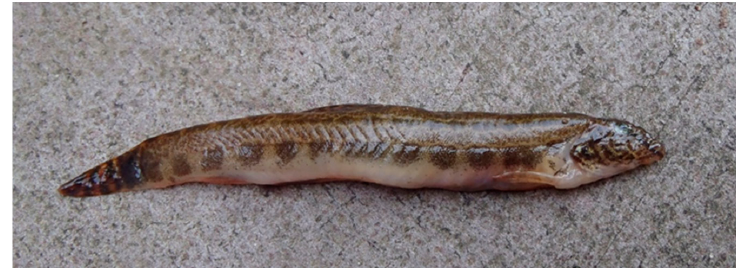
110 individuals. an abundance of